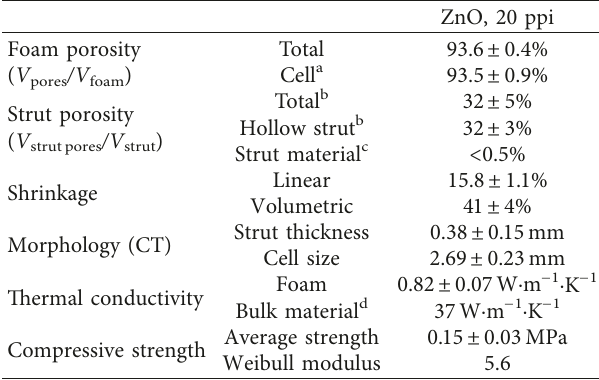
a Including the cavities resulting from the PU template burnout. b Related to the overall strut volume; V hollow strut /( V hollow strut + V strut material pores + V solid ) and V strut material pores /( V hollow strut + V strut material pores + V solid ). c Related to the volume of the strut material excluding the cavities resulting from the PU template burnout; V strut material pores /( V strut material pores + V solid ). d Extrapo- lated thermal conductivity of the bulk strut material according to Ashby’s model [43].